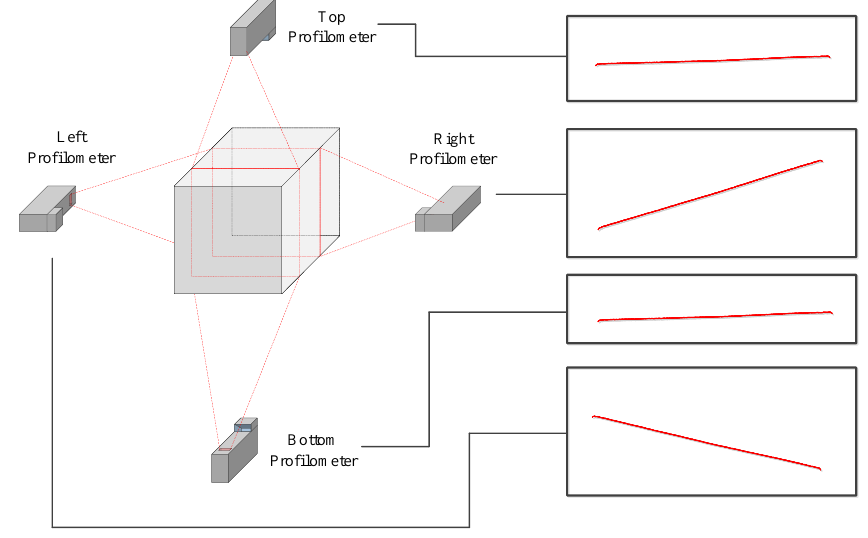
Figure 1. Profile